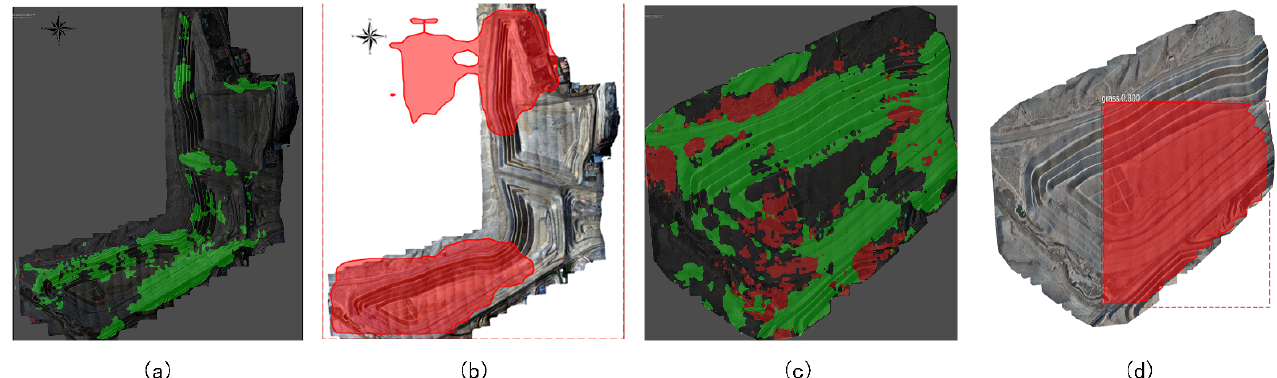
Figure 12. Comparison with Mask-RCNN algorithm, ( a ) results obtained using semantic segmentation for the Luotuo Mountain drainage field, ( b ) results obtained using instance segmentation for the Luotuo Mountain drainage field, ( c ) results obtained by using semantic segmentation for the Mengxi drainage field, ( d ) results obtained using instance segmentation for the Mengxi drainage field. The green area in ( a , c ) represents grass. The red area in ( a , c ) represents land. The red area in ( b , d ) represents grass.